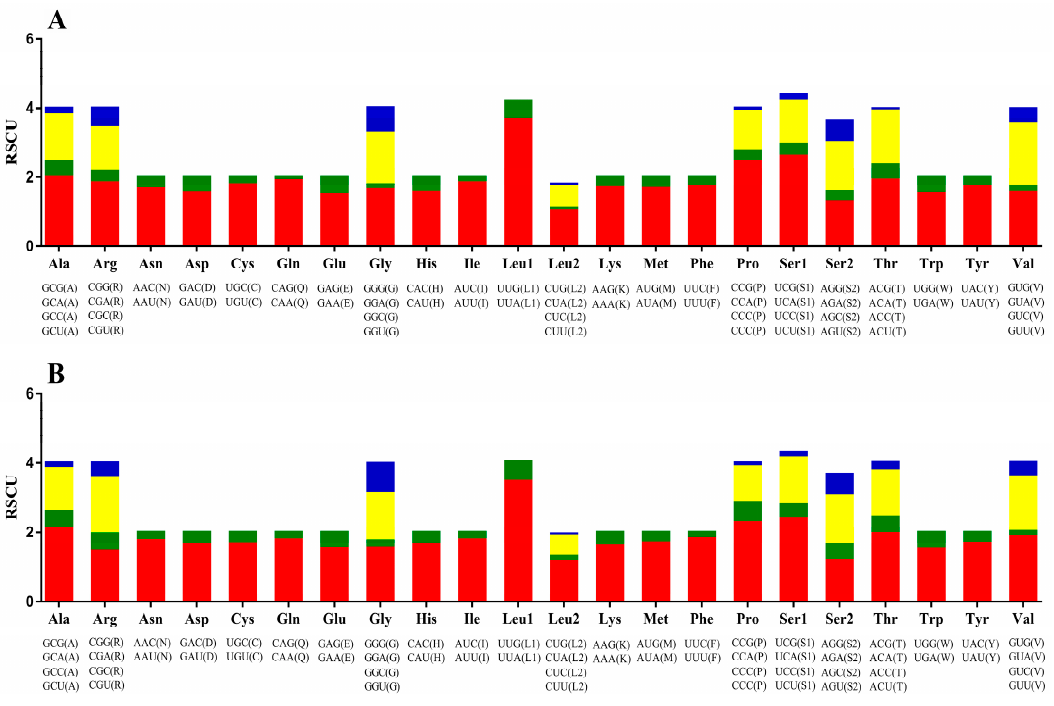
Figure 3. The relative synonymous codon usage (RSCU) in the mitogenomes of ( A ) P. bilineatus and ( B ) Meghimatium bilineatus .